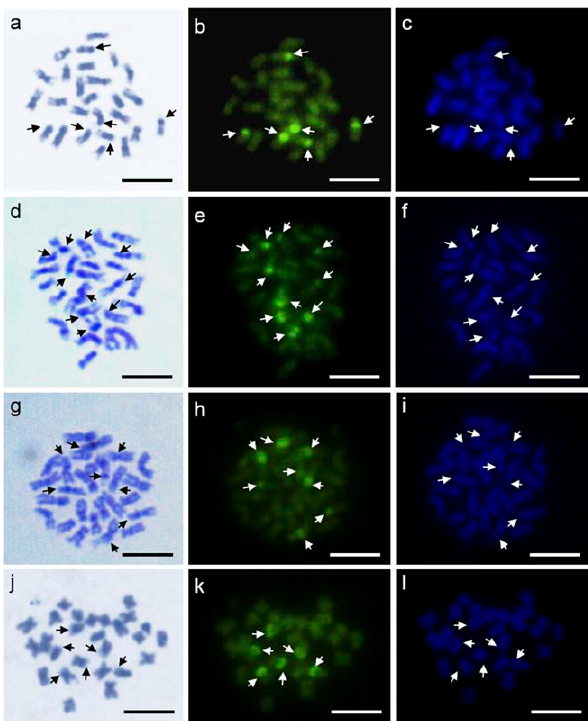
Figure 3. Somatic metaphase chromosomes (2n= 26) of four Indi- an landraces of S. indicum stained with Giemsa, CMA followed by DAPI. a- c) Black seeded til; d- f) Dark Brown seeded til; g- i) Light Brown seeded til; j- l) White seeded til. Bar= 5 µm. Arrows indicate the chromosomes showing CMA +ve signals/ zones when stained with CMA fluorochrome.